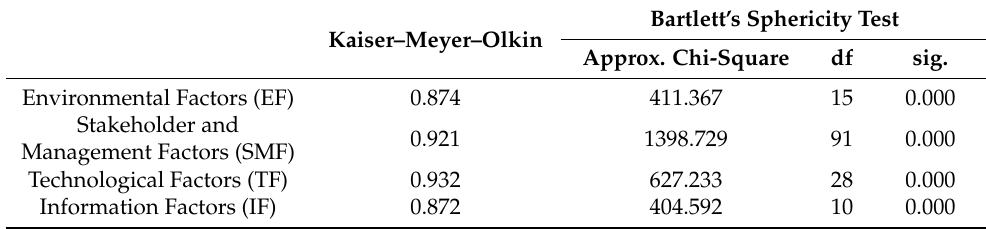
Table 3. KMO and Bartlett’s test of observed variables.